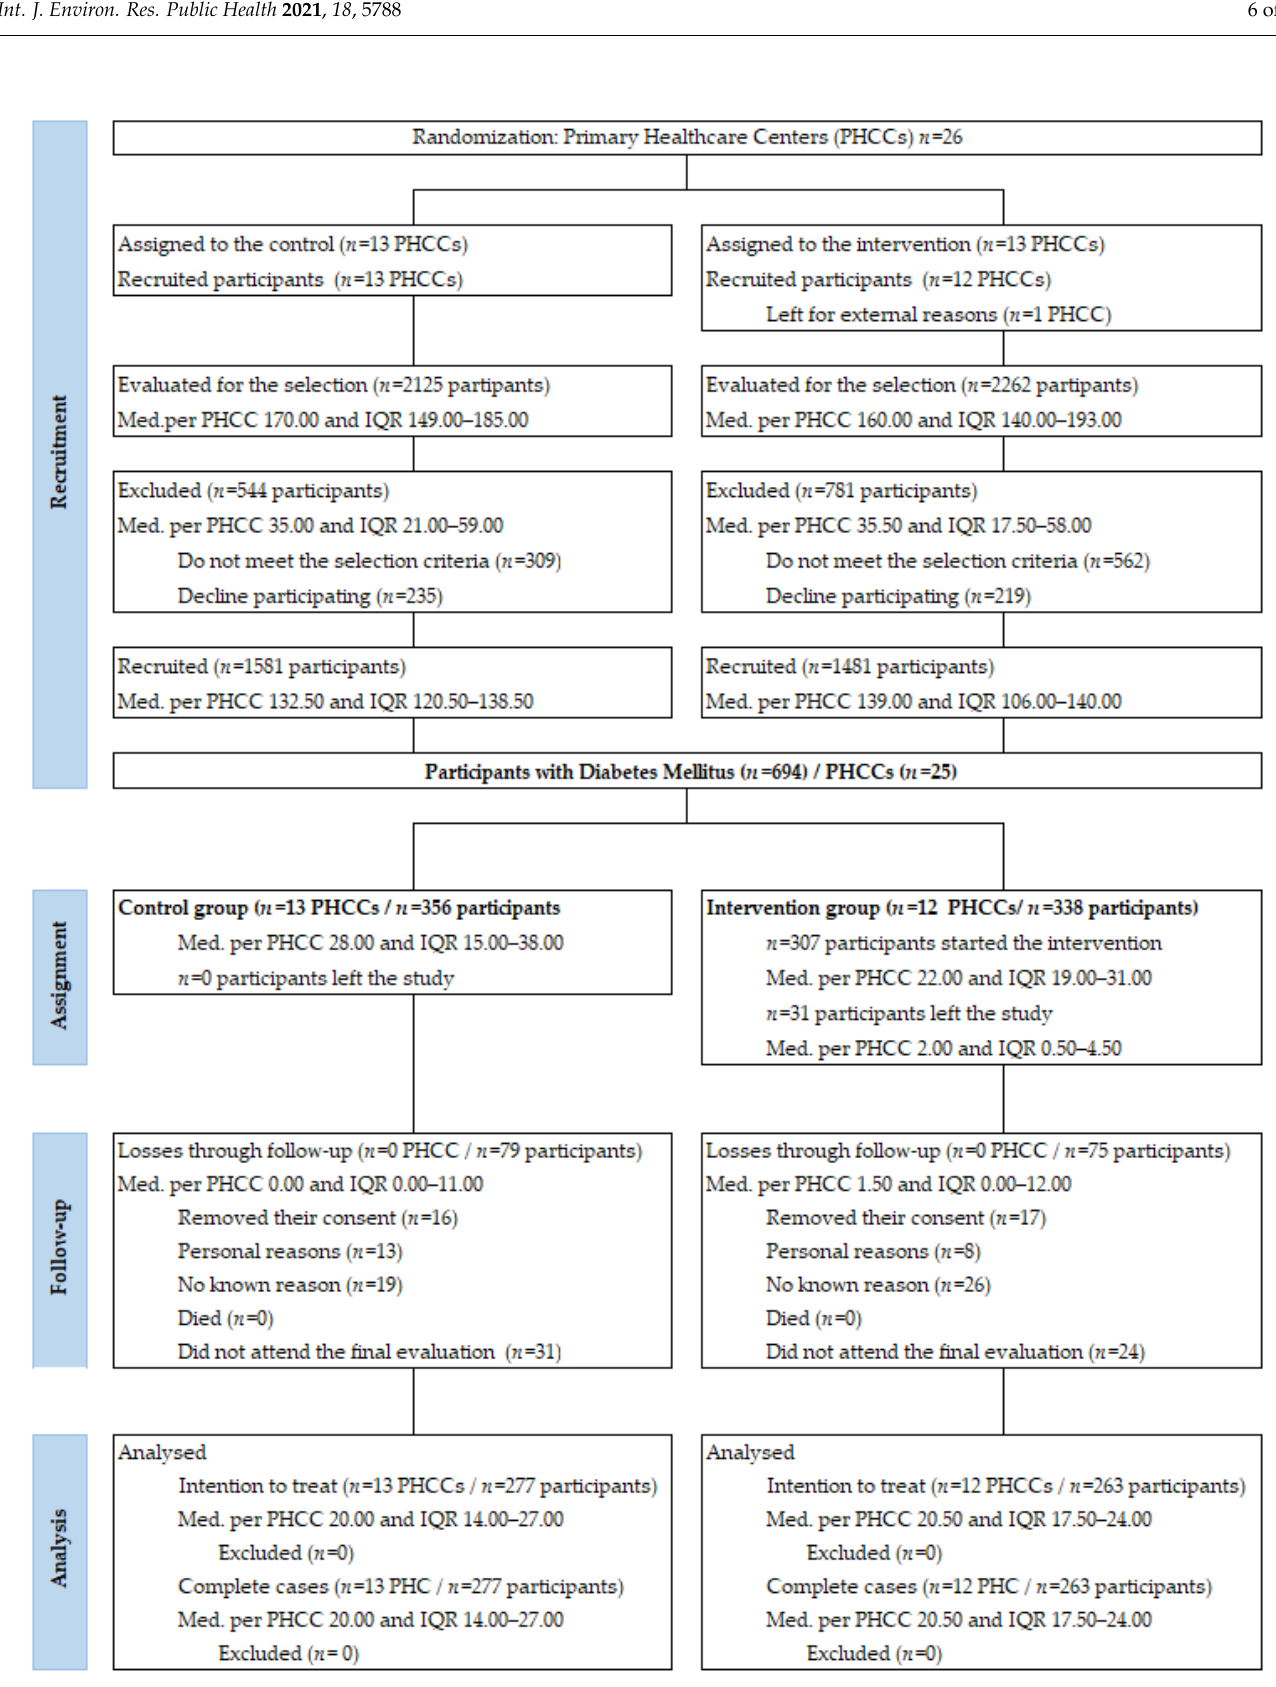
Figure 1. Flow diagram of the study.